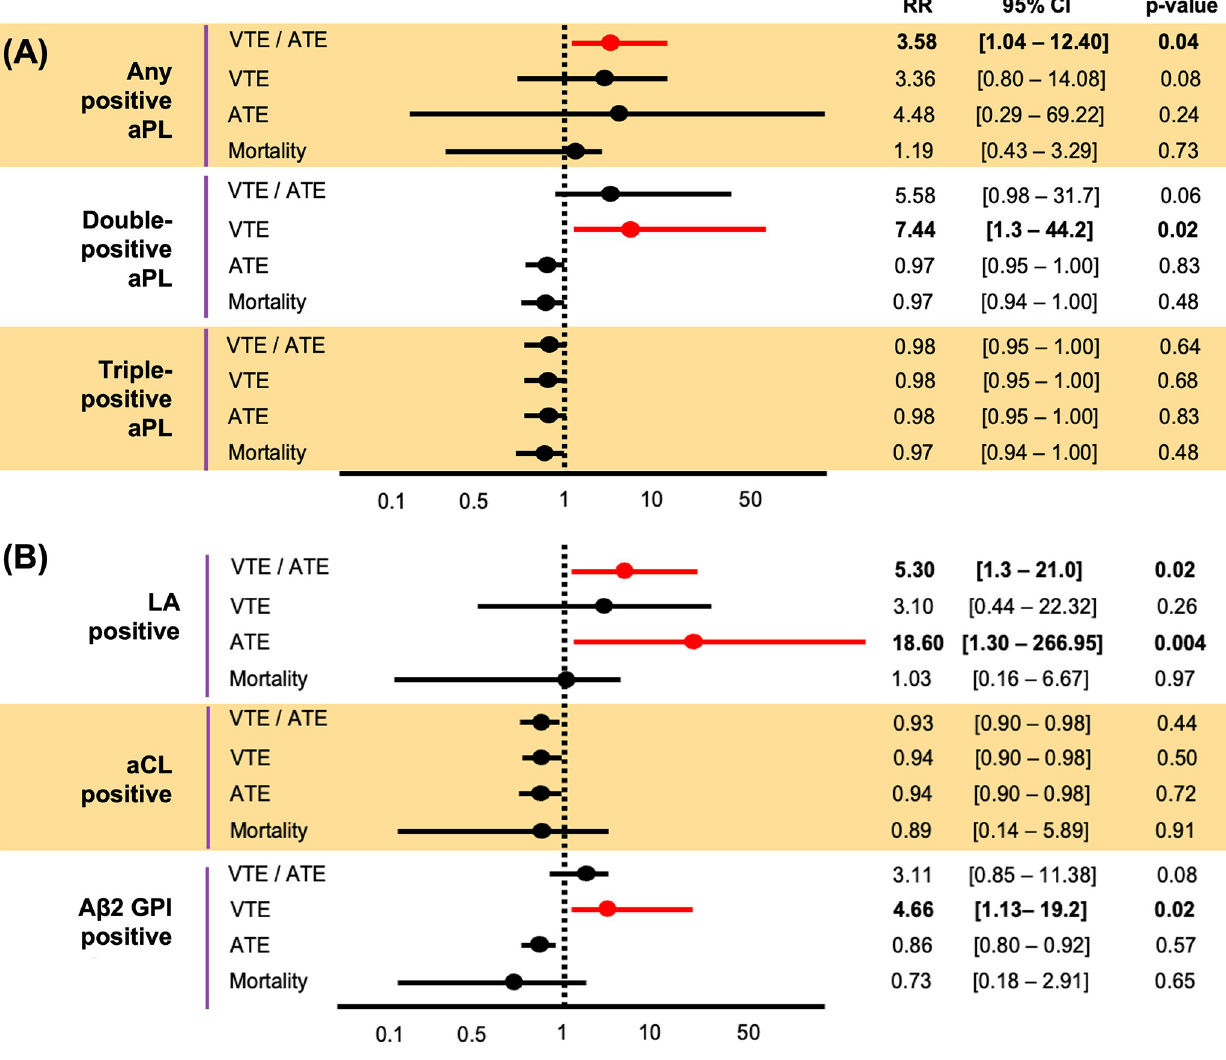
Fig 4. (A) Association of thrombotic outcomes and numbers of positive aPL, and (B) types of positive aPL status in ambulatory cancer patients. Abbreviations: ATE = arterial thrombotic events, aCL = anticardiolipin, LA = lupus anticoagulant, a β 2GPI = anti-beta-2 glycoprotein